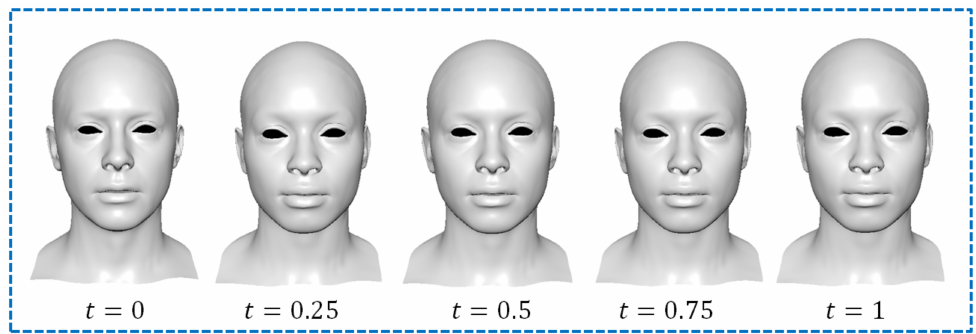
Figure 11. Facial blendshapes created by using Equation (29) with w 1 = 0.35, w 2 = 0.3, and w 3 =